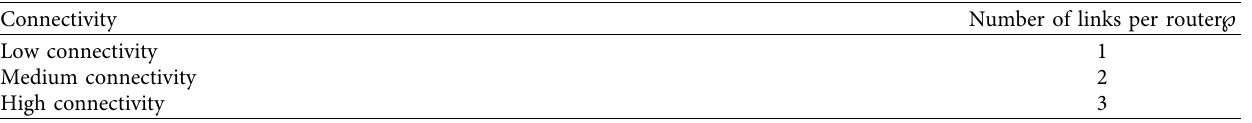
Figure 5: Randomly generated sample network topologies with different network connectivities defined in Table 7. (a) Low connectivity. (b) Medium connectivity. (c) High connectivity. Table 7: Network